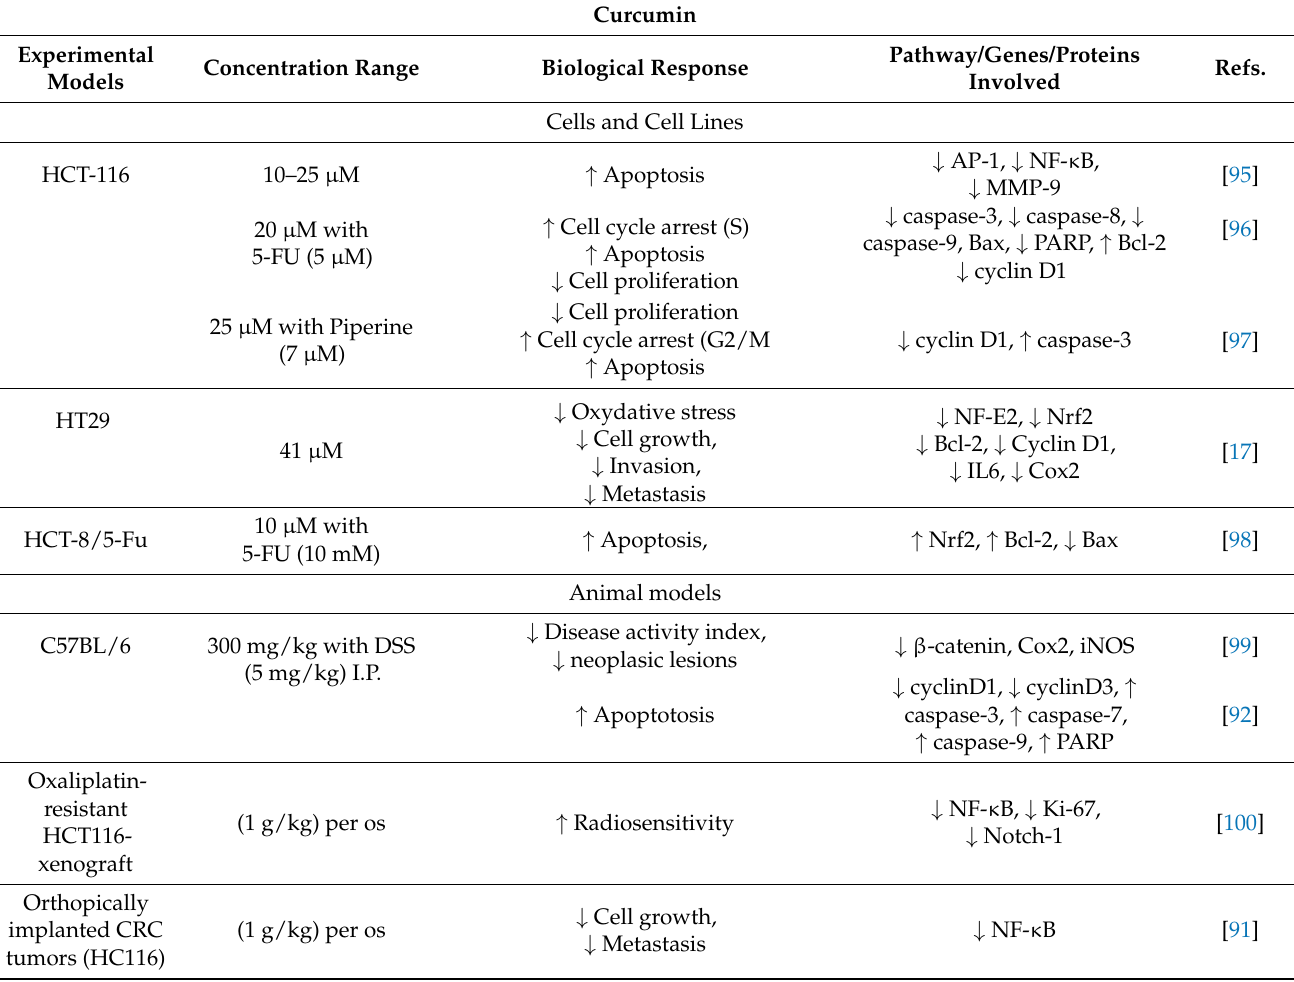
Table 5. Antitumoral effects of curcumin in colorectal cancer.